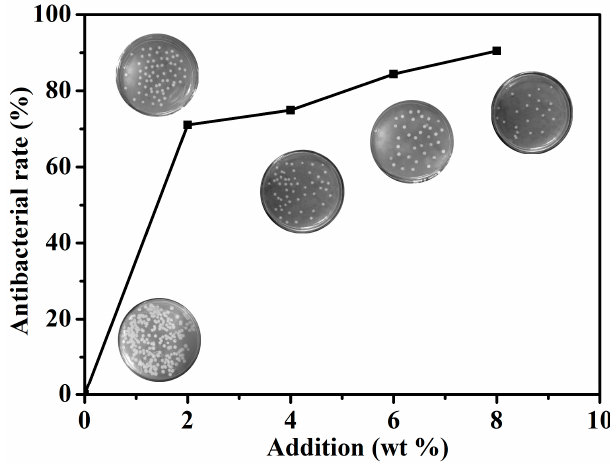
Figure 10. Effects of different additives on antibacterial rate ( E. coli ).